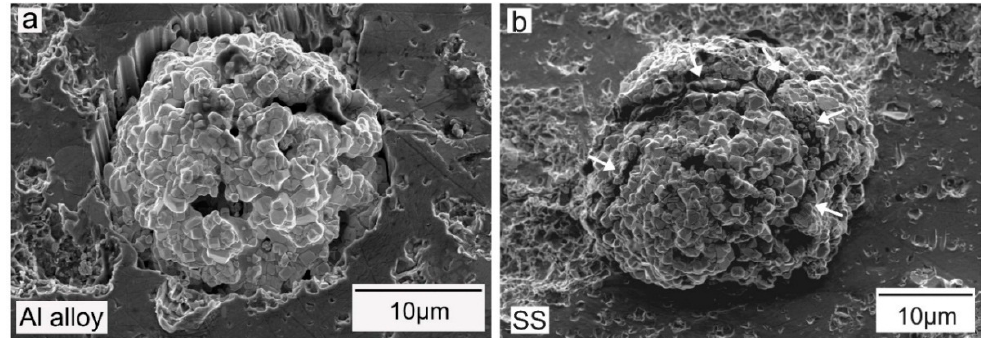
Figure 3. SEM imaging of surface morphology of a WC-Co particle after deposition on ( a ) Al alloy and ( b ) SS substrates.